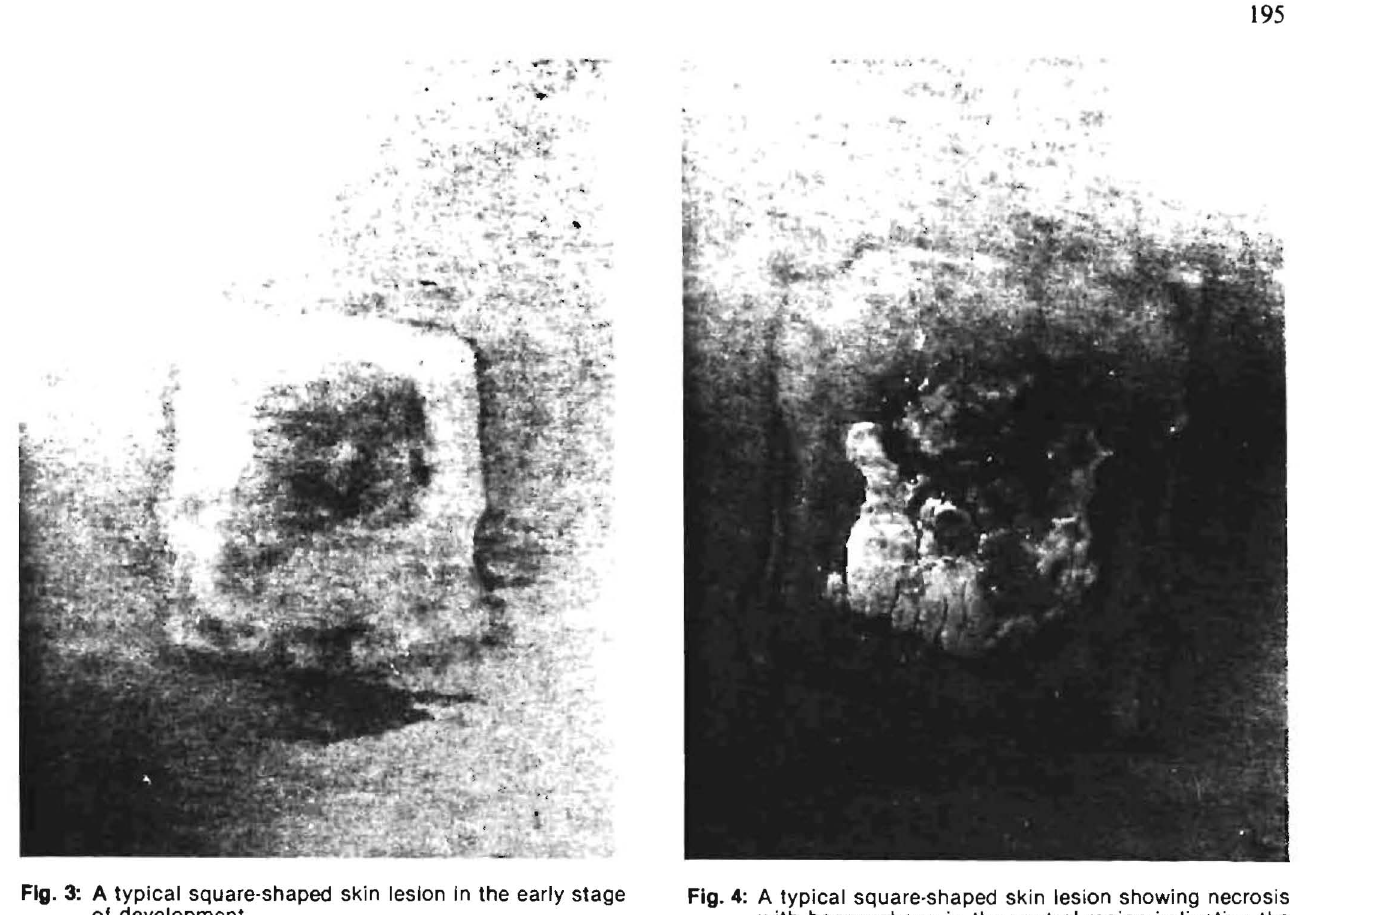
Fig. 4: A typical square·shaped skin lesion showing necrosis with haemorrhage in the central region indicating the progression of the lesion.